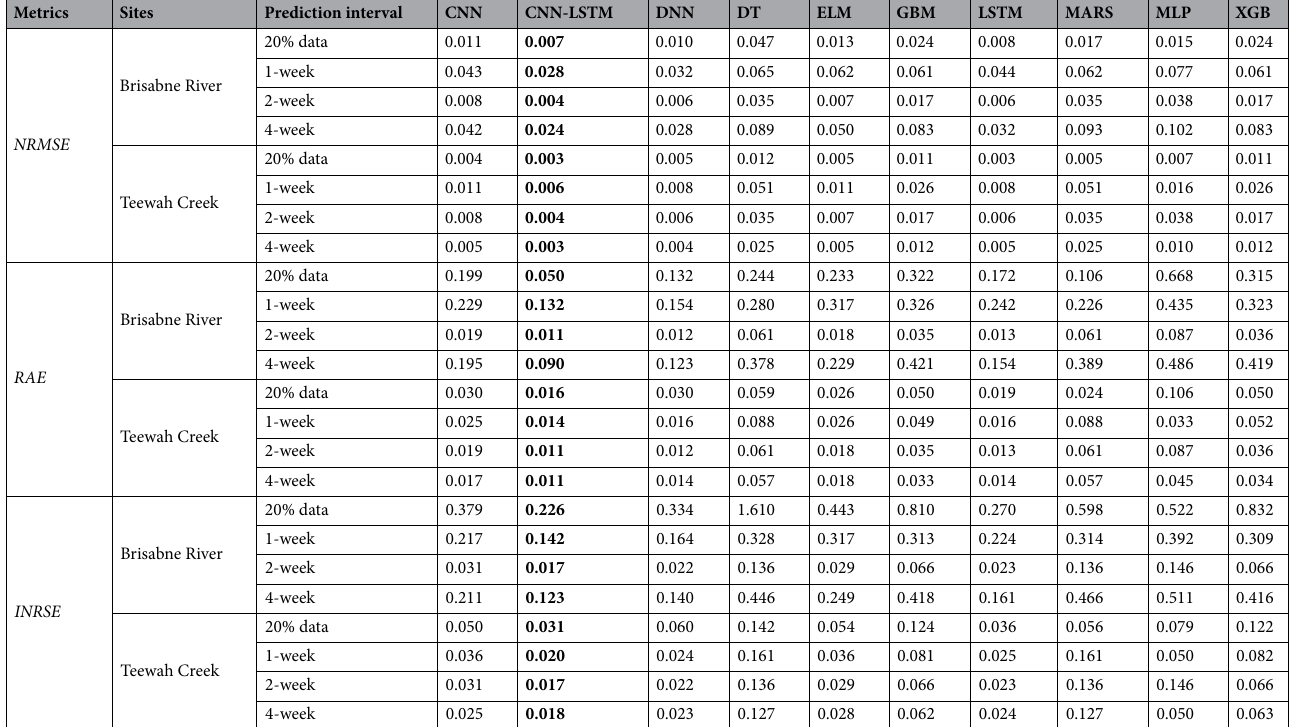
Table 6. Comparison of CNN-LSTM model performances with the comparative counterpart models: Convolutional Neural Network (CNN) and Long Short Term Memory Network (LSTM) as well as the Deep Neural Network (DNN), Multi-Layer Perceptron (MLP), Extreme Learning Machine (ELM), Gradient Boosting Regression (GBM), Decision Tree (DT), Multivariate Adaptive Regression Splines (MARS) and Extreme Gradient Boosting Regression (XGB) model, as measured by Normalized root mean squared error (NRMSE), relative absolute error (RAE) and Integral normalized root squared error (INRSE) in the testing phase. Prediction was done for 1-h horizon for 20% of total data (9-Months), 1-Week (1W), 2-Week (2W) and 4-Week (4W) Best Model is highlighted in